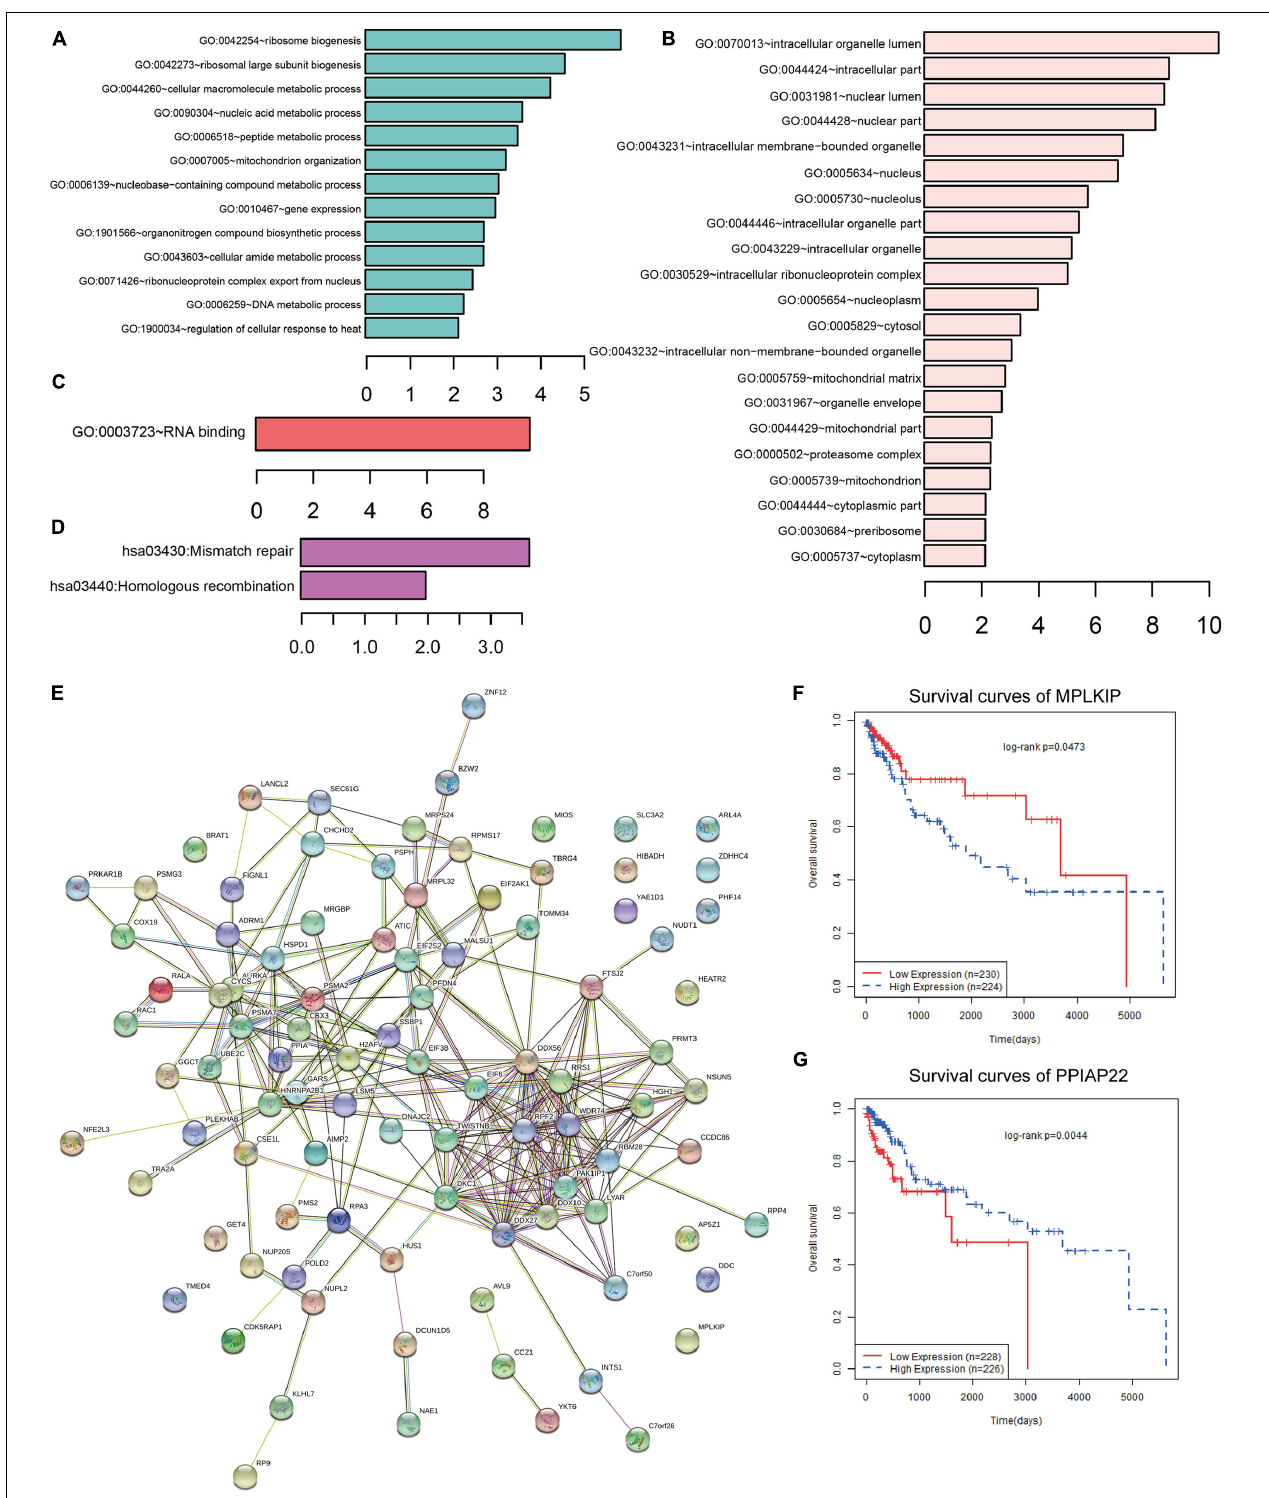
FIGURE 8 | Functional analysis of CCT6A in COAD. (A) GO BP, (B) GO CC, (C) GO MF and (D) KEGG pathway enrichment analysis of CCT6A associated genes. (E) The PPI network of CCT6A related genes using the STRING online database. (F,G) Kaplan-Meier survival curves of MPLKIP and PPIAP22 in COAD patients.